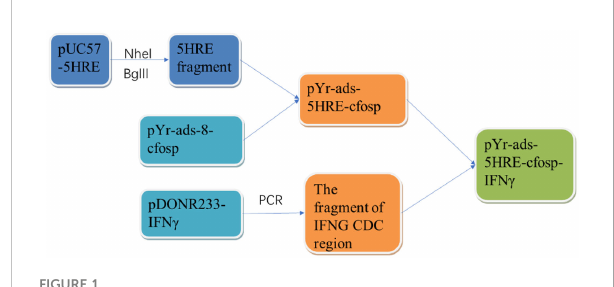
FIGURE 1 Flowchart of construction of pYr-ads-8-5HRE-cfosp-IFNG